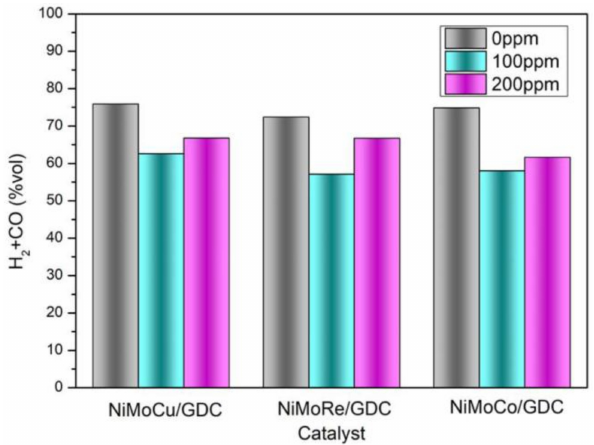
Figure 9. Sulfur impact on the syngas selectivity of catalysts (800 ◦ C, 10 h, 120,000 h − 1 space